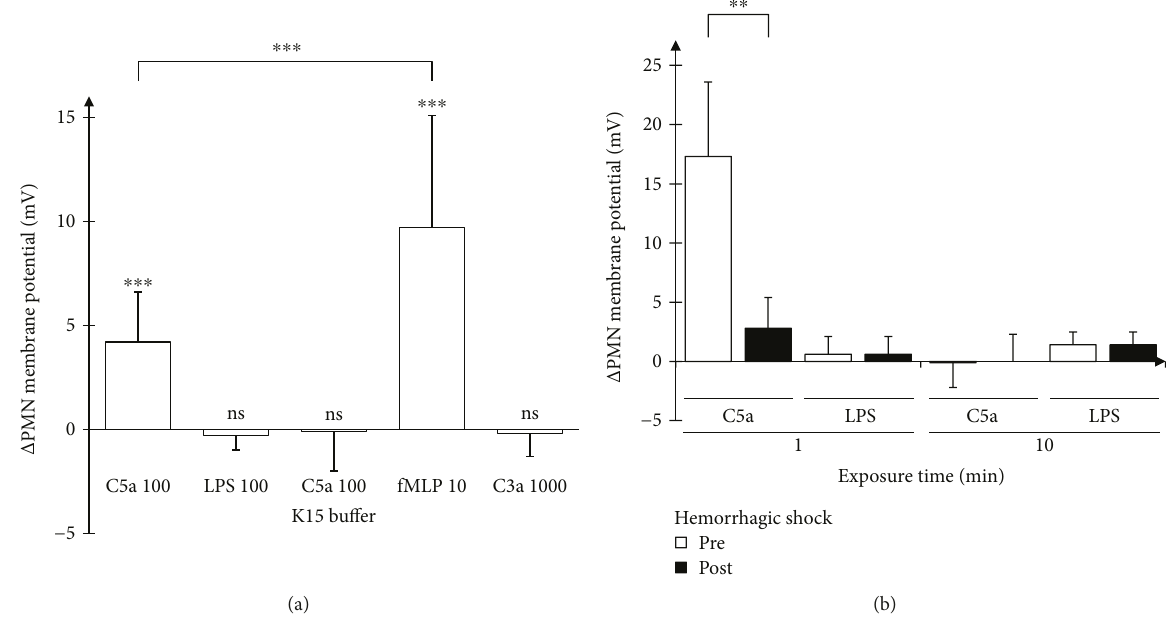
Figure 6: (a) Assessment of further stimulants. Change in membrane potential of human PMN when exposed to di ff erent substances (each in ng/ml, expect fMLP in μ M, n = 45 ; 6 ; 8 ; 10 ; 3 ). (b) Membrane potential of PMN in hemorrhagic shock. Change in membrane potential of porcine PMN before and after hemorrhagic shock (C5a or LPS 100ng/ml, n = 4 ; 5 ). ∗∗ p < 0 01 and ∗∗∗ p < 0 001